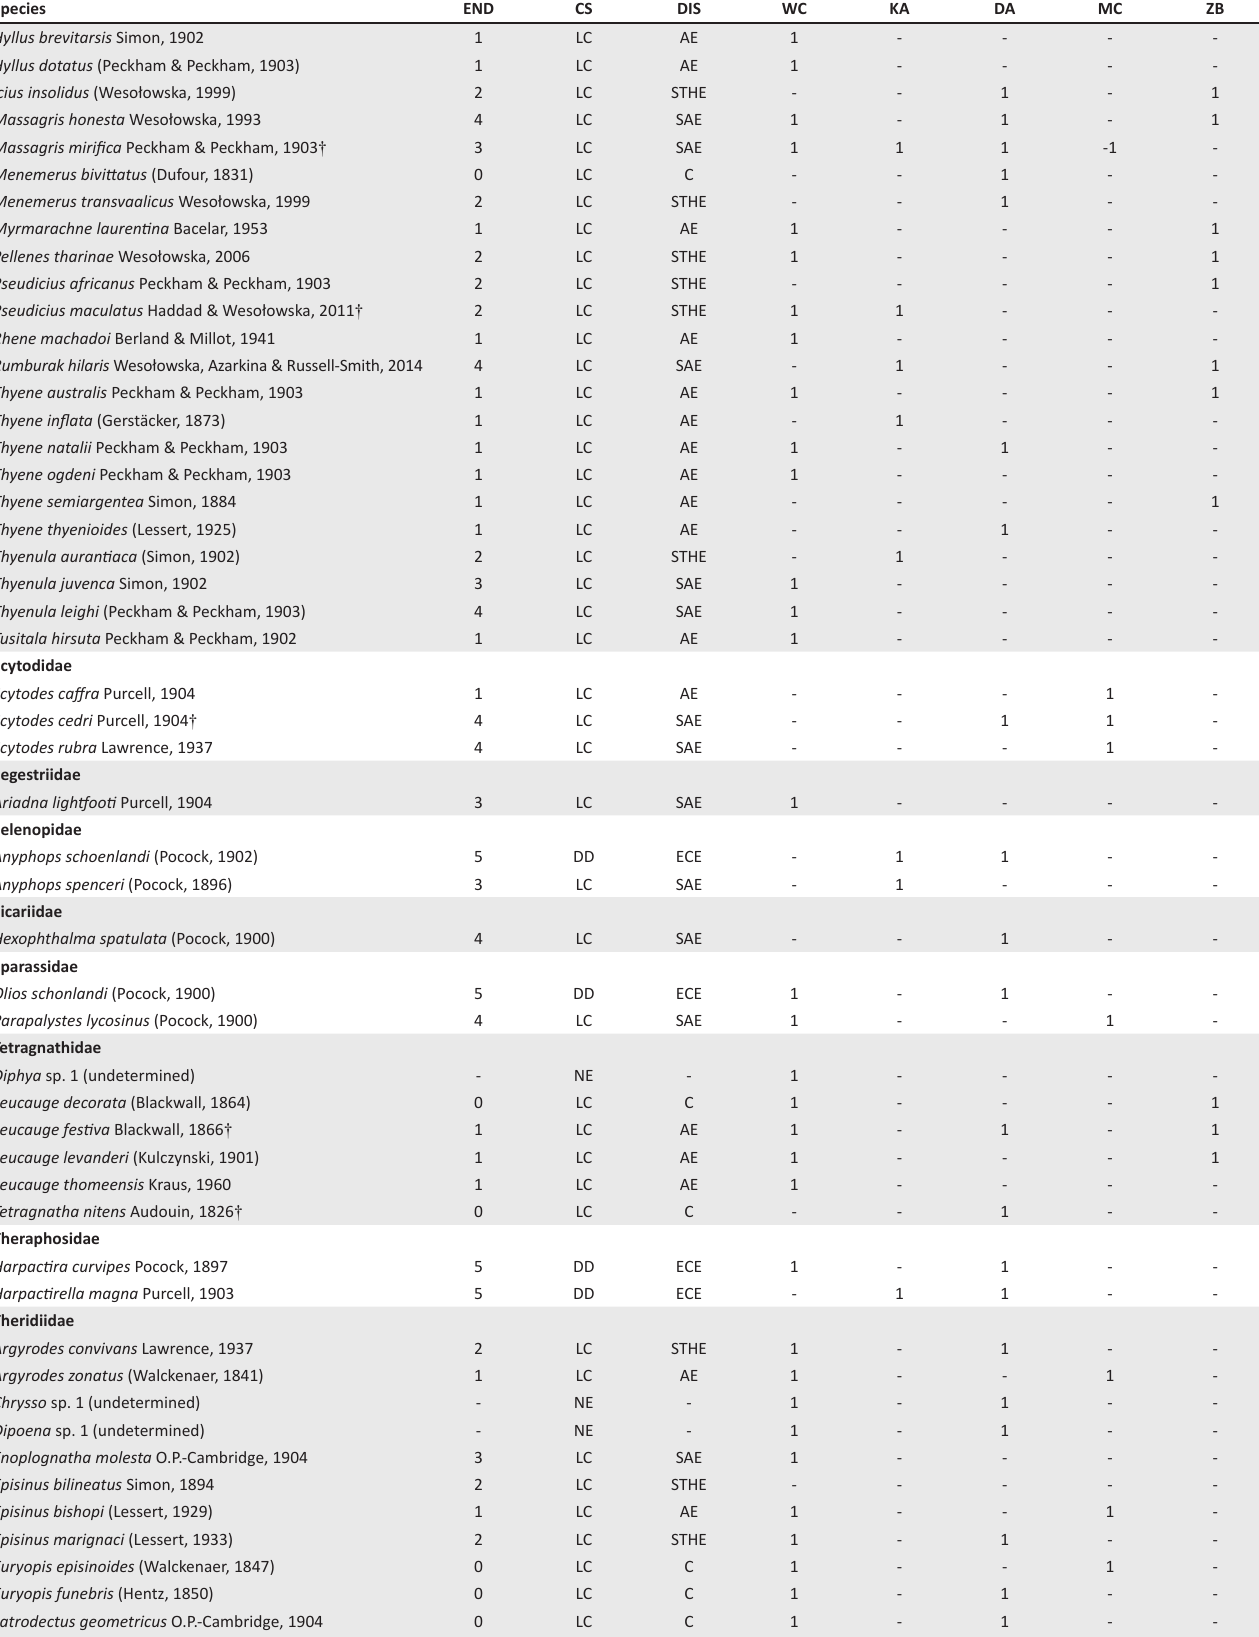
TABLE 1-A1 (Continues): Spiders of the Addo Elephant National Park, listing their endemicity, conservation status, distribution and areas sampled in the park. Species